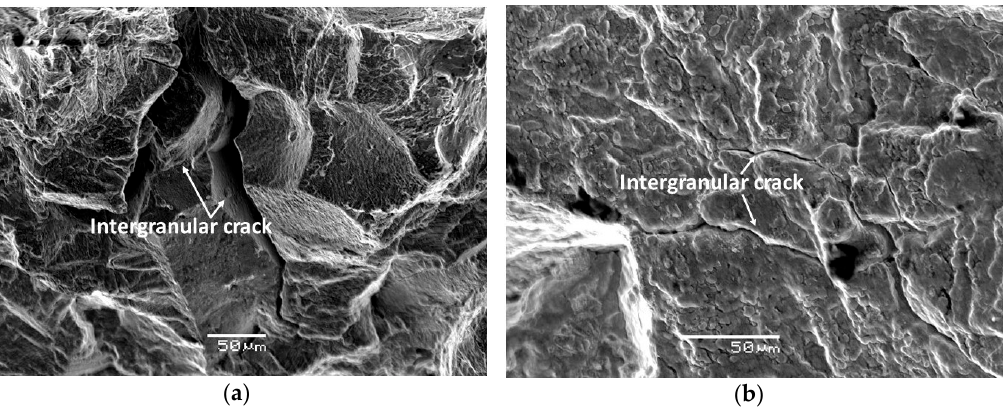
Figure 14. Typical SEM images for LCF test with HT of Alloy 800H: ( a ) BM and ( b ) weldments. The arrows indicate the intergranular crack shown in both pictures.